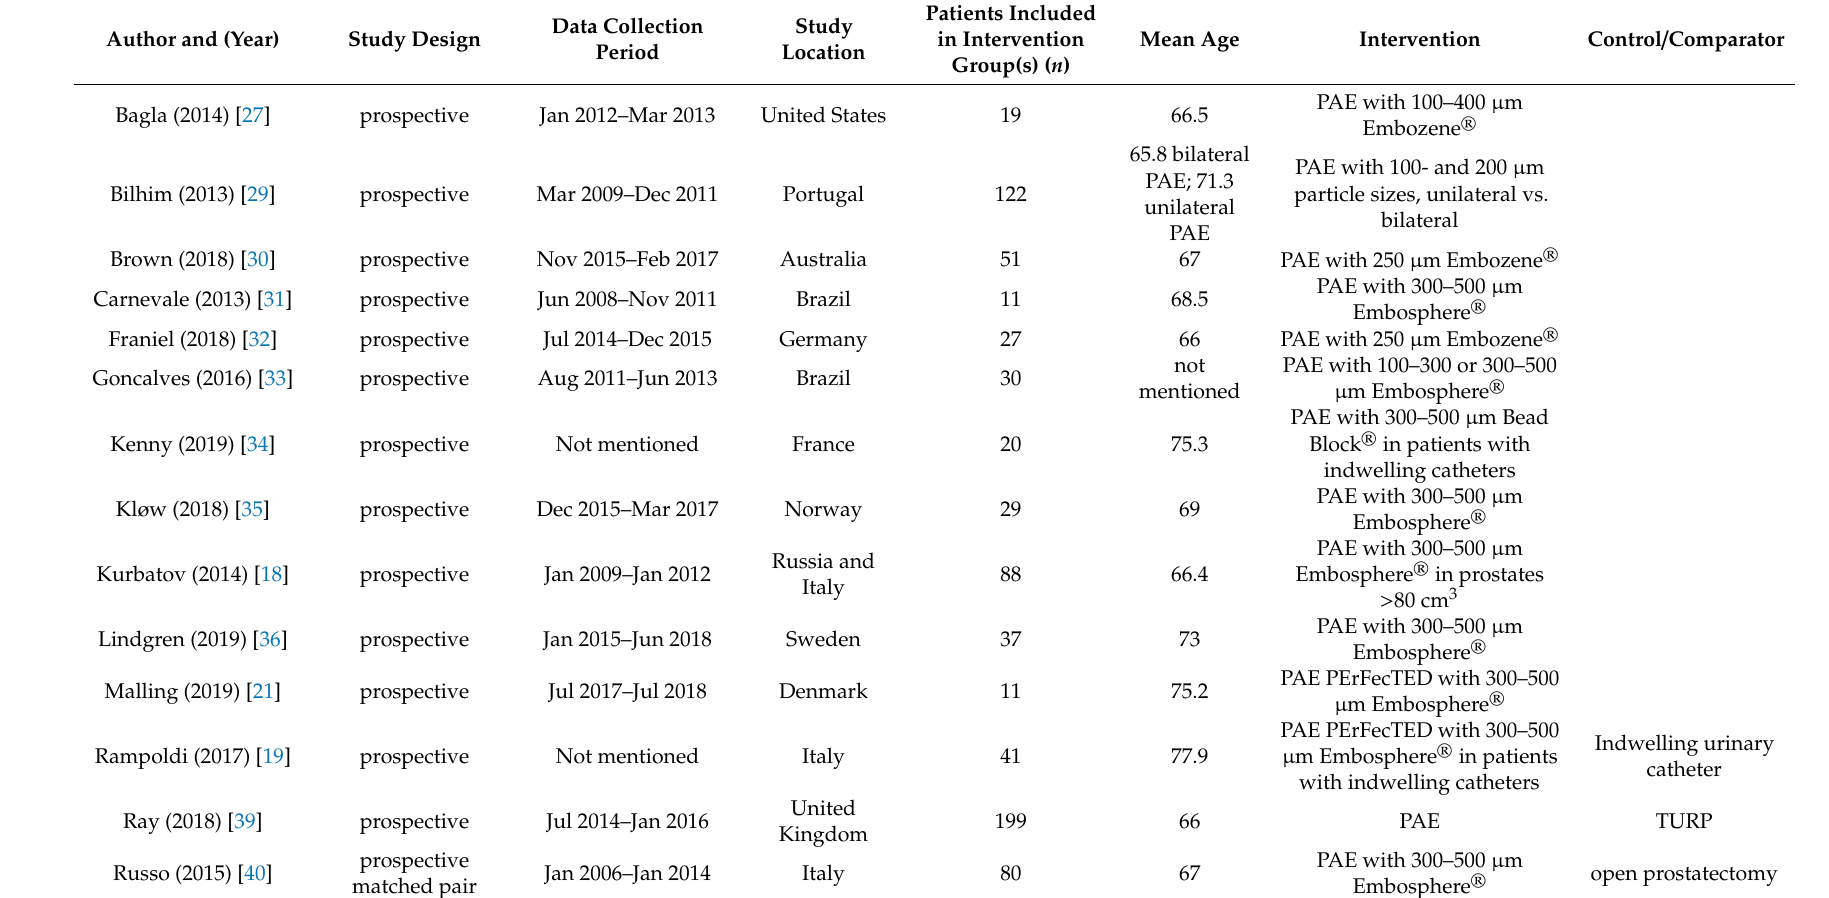
Table 2. Study characteristics of prospective